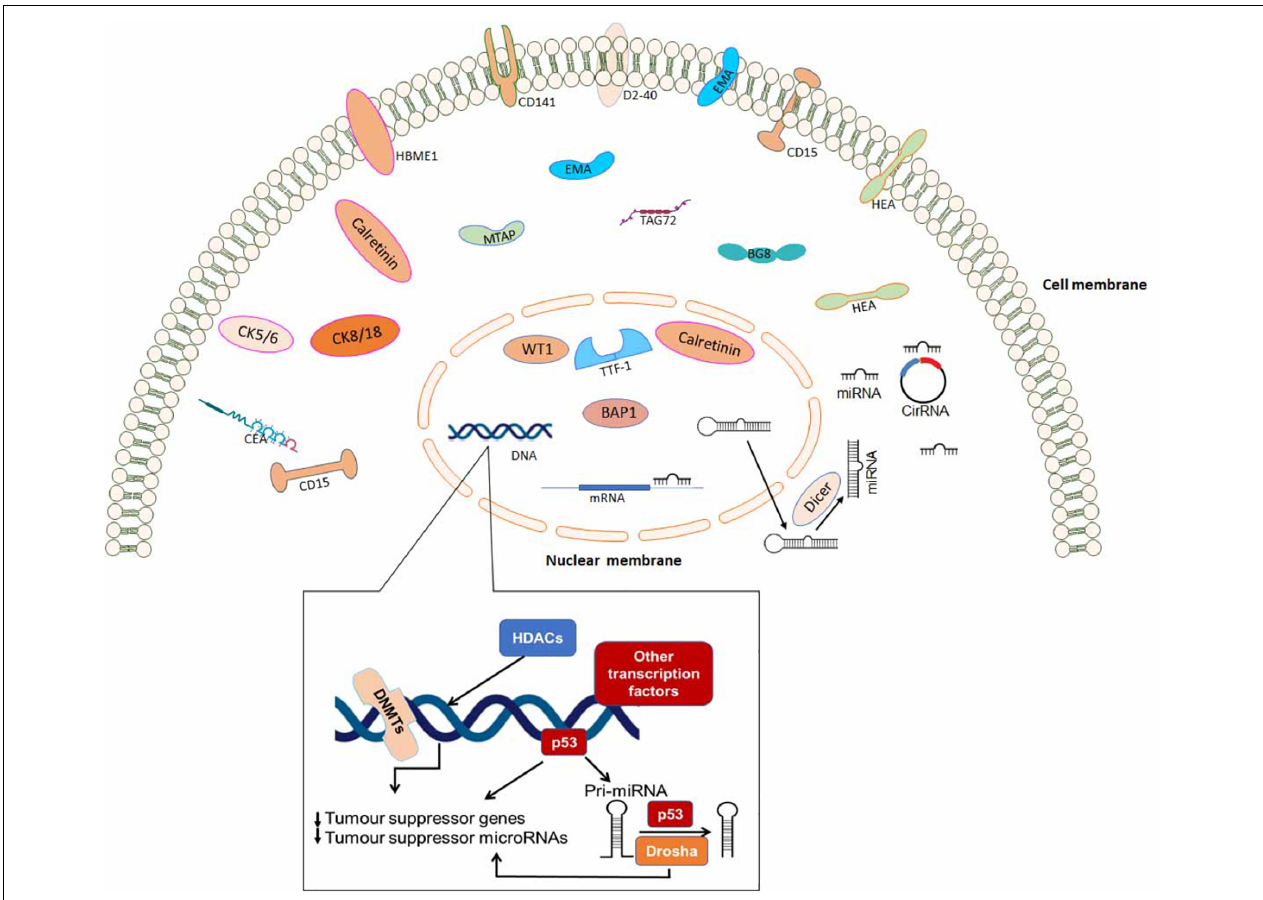
FIGURE 2 | A schematic diagram indicating protein localization for immunohistochemistry staining and epigenetic biomarkers in mesothelioma cell.